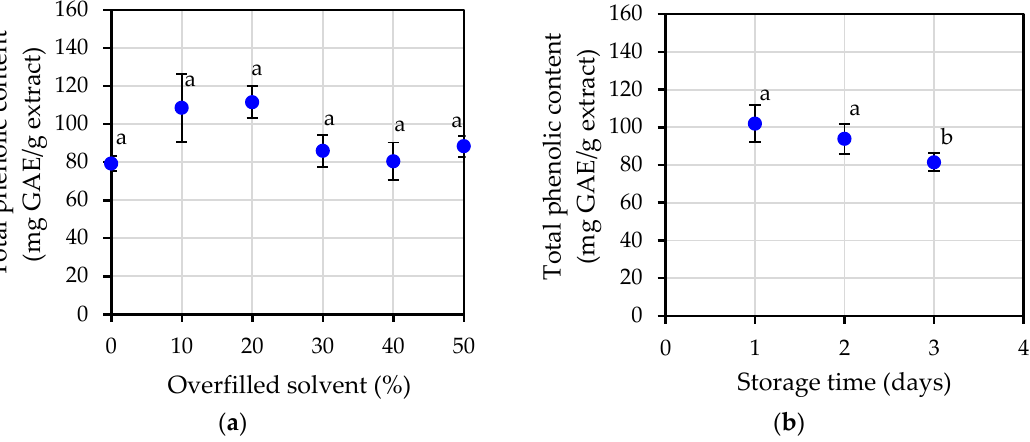
Figure 3. Total phenolic content of jasmine essential oil: ( a ) at varying percentage of overfilled solvent; ( b ) at varying storage time. Different letters a, b in the same figure indicate that values are significantly different ( p < 0.05).